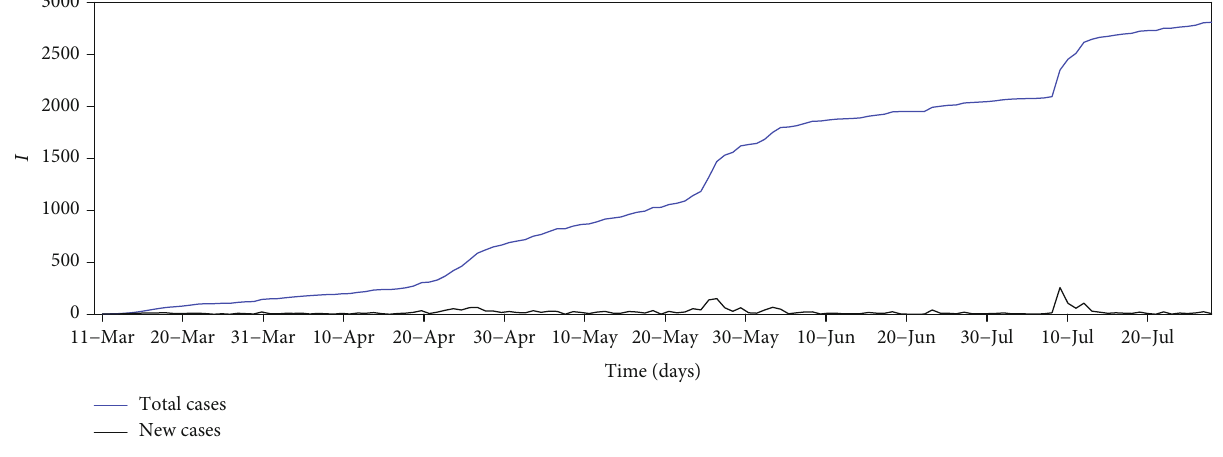
Figure 1: Reported COVID-19 cases from 11 th March 2020 to 29 th July 2020, Sri Lanka (source: Epidemiology Unit, Ministry of Health, Sri